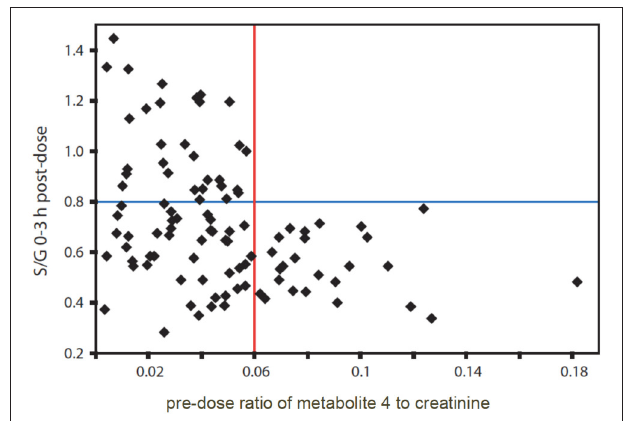
FIGURE 4 | The relationship between the 0–3 h post-dose ratio of paracetamol sulfate to paracetamol glucuronide (S/G) and the pre-dose ratio of metabolite 4, normalized to creatinine in the urines from human volunteers on the paracetamol trial. Adapted from PNAS ( Clayton et al.,